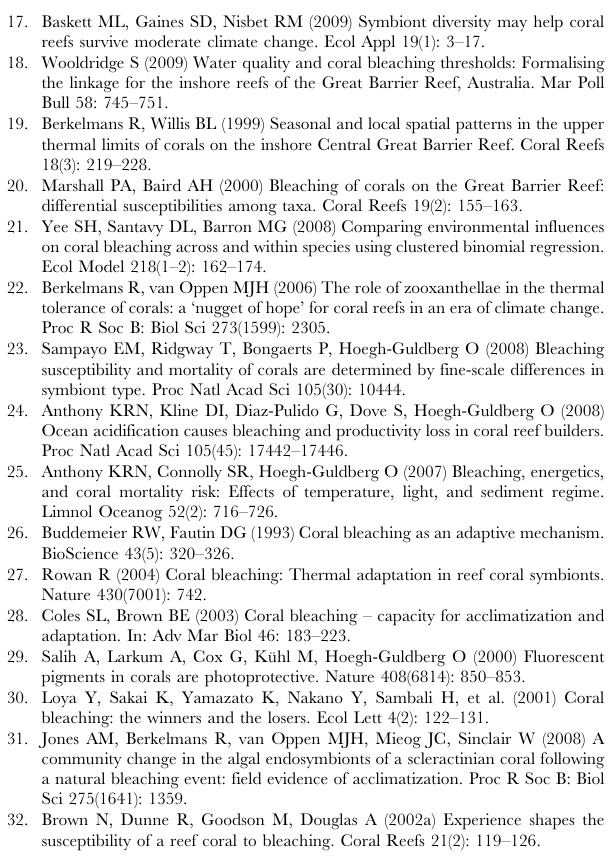
Figure S1 Annual coral calcification rates. Calcification rates for individual coral cores standardized such that the long- term average for each record is equal to 1 g/cm 2 /year. (TIF) Figure S2 Annual average coral density. Annual average skeletal density for individual coral cores standardized such that the long-term average for each record is equal to 1 g/cm 3 /year. (TIF) Table S1 Average coral extension rate (cm/year), density (g/cm 3 /year), and calcification rates (extension * density; g/cm 2 /year) from individual sites, and from island groups used in